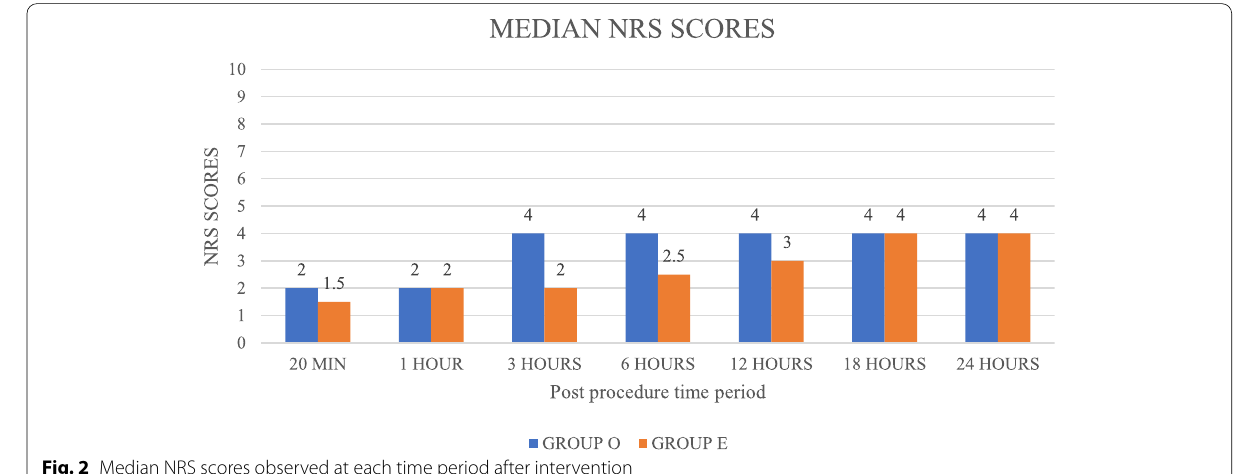
Fig. 2 Median NRS scores observed at each time period after intervention